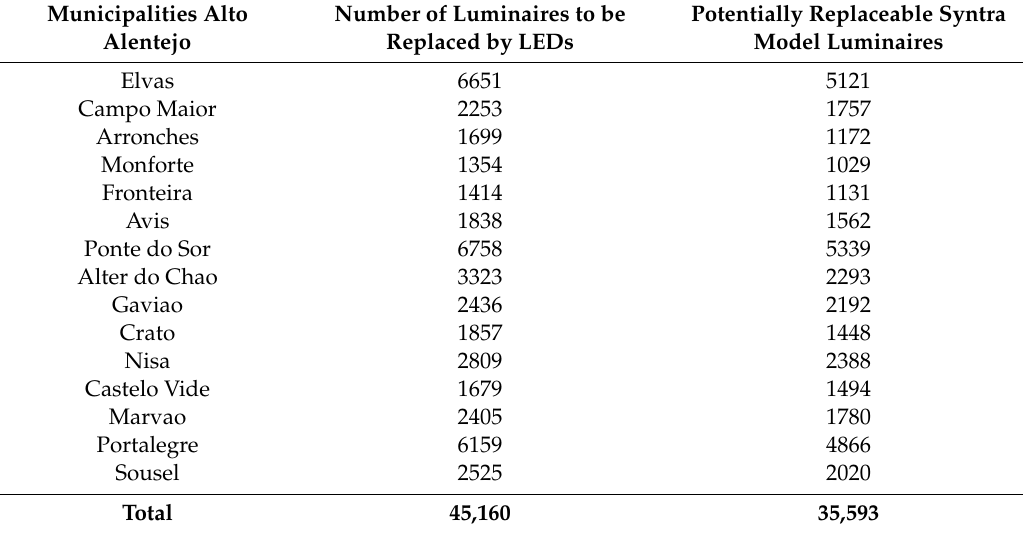
Table 1. Total number of luminaries inventoried in the Alto Alentejo area by municipalities (Source: IluPub).